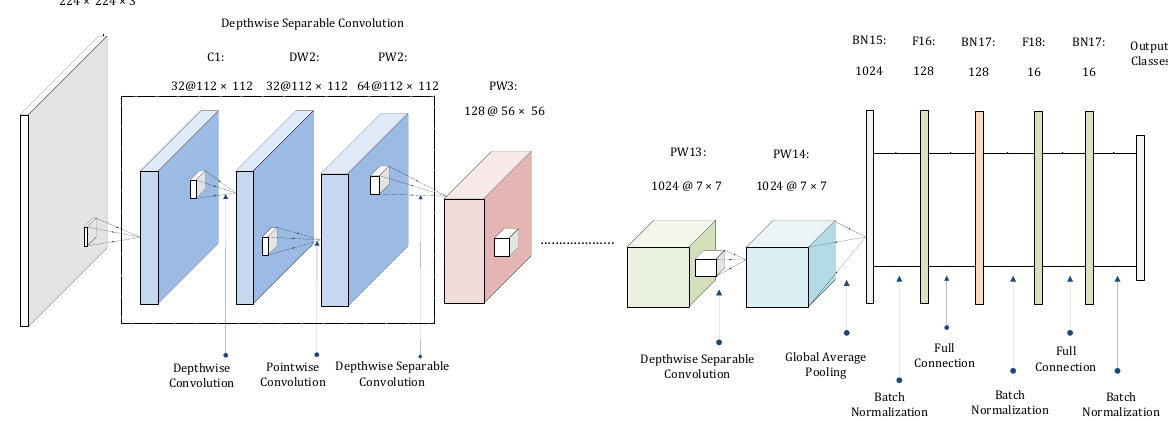
Figure 2. Improved MobileNet-V1 Transfer Learning